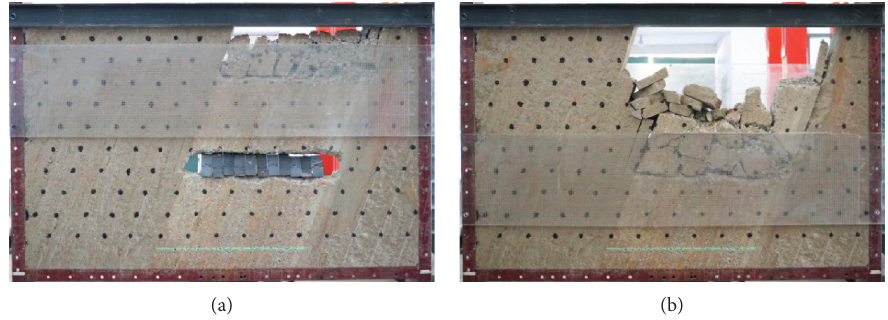
Figure 8: Upper section coal drawing process. (a) Before upper section coal drawing. (b) After upper section coal